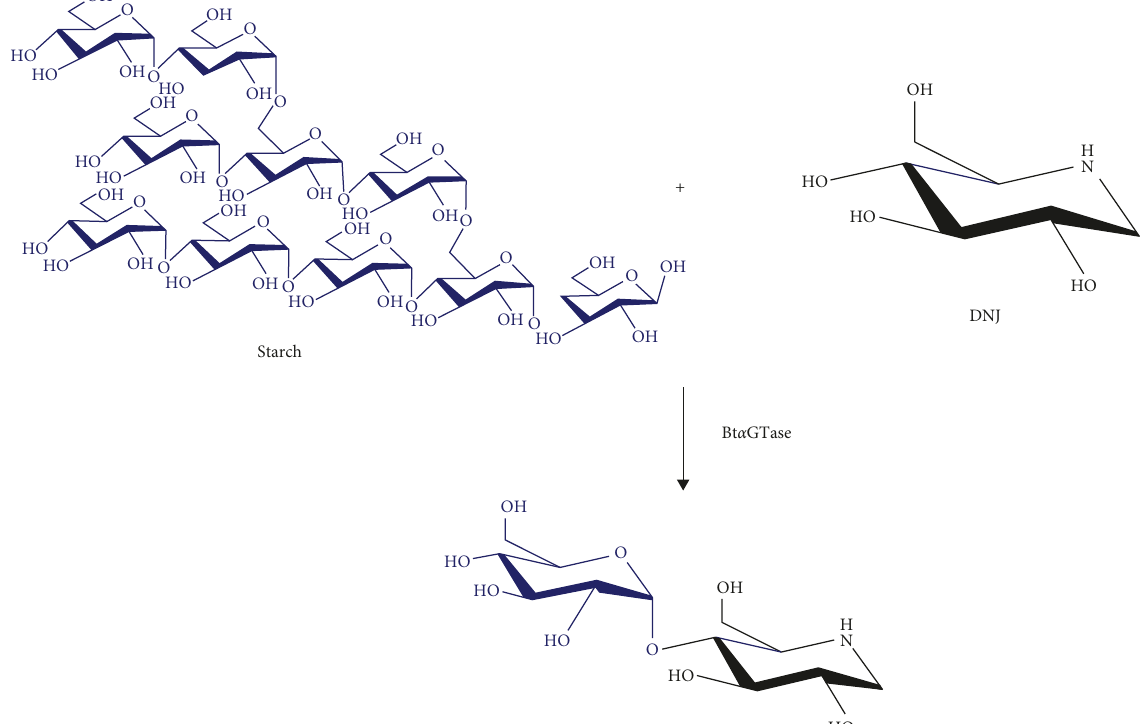
Figure 4: Production of 1-deoxynojirimycin (DNJ) glycosides using Bt α GTase from DNJ and starch.